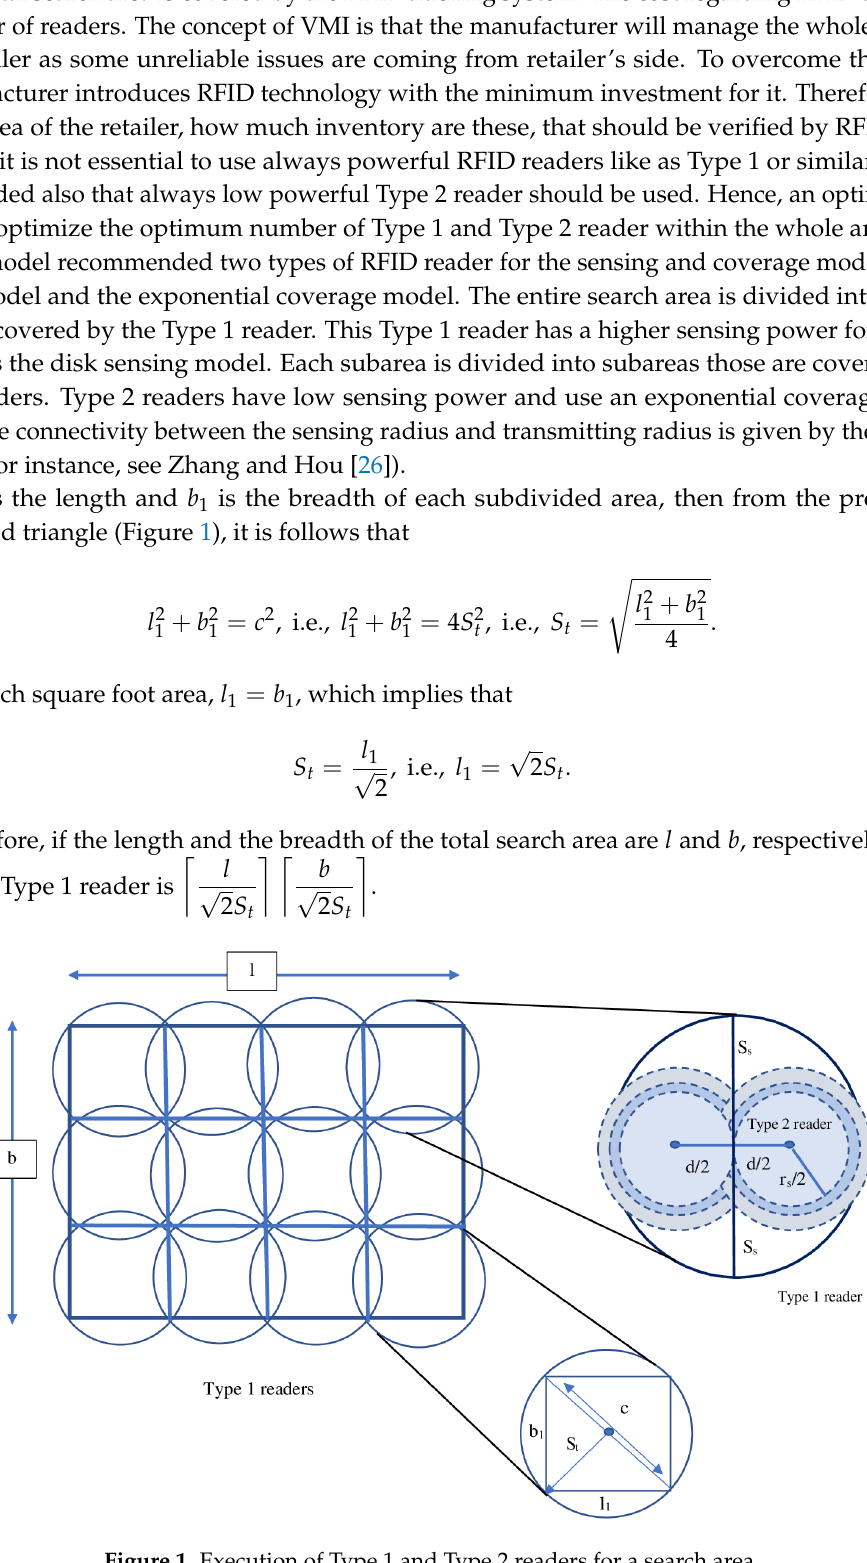
Figure 1. Execution of Type 1 and Type 2 readers for a search